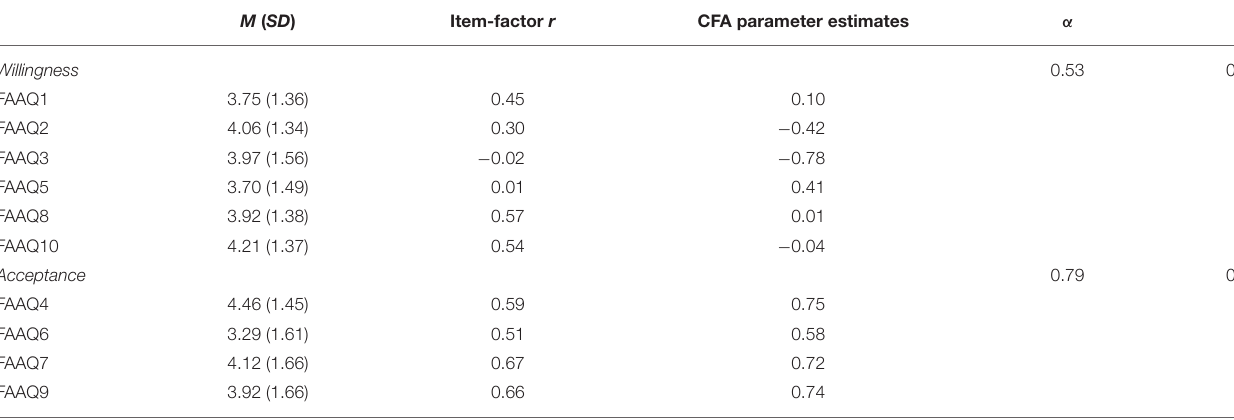
TABLE 2 | Descriptive statistics of the items, item-factor correlations, CFA parameter estimates, and internal consistency.